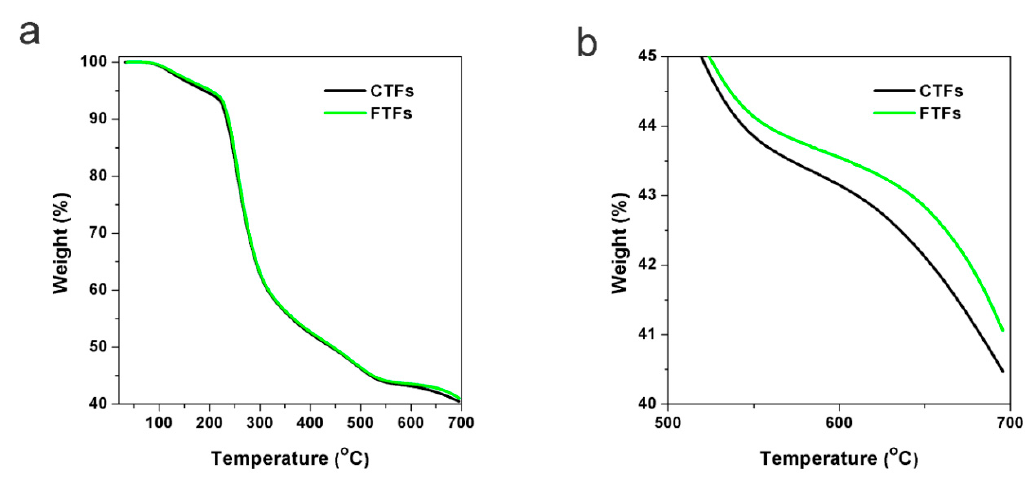
Figure 4. Thermogravimetric analysis (TGA) spectra of CTFs and FTFs: ( a ) the whole weight loss process; ( b ) magnified spectrum of the partial weight loss process.